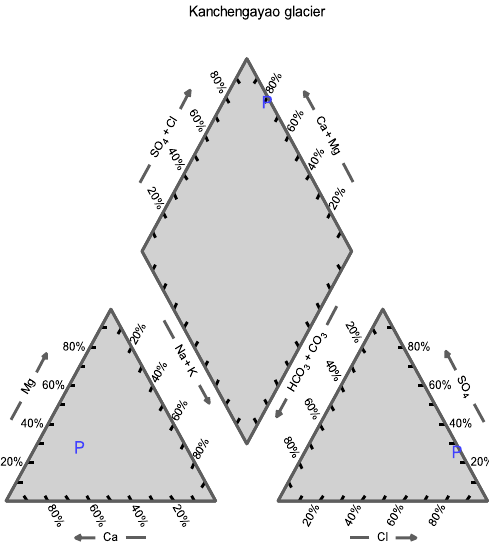
Fig. 1. Piper diagram of Kanchengayao glacier